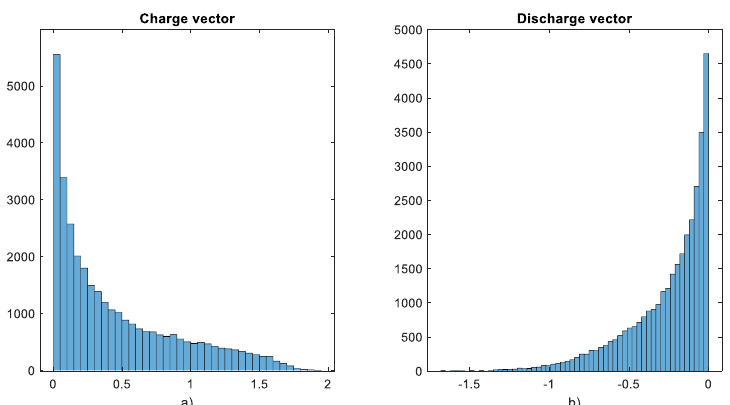
Figure 7. Histograms of the charge vector ( a ) and the discharge vector ( b ) with ramp-rate limitation of 1%.